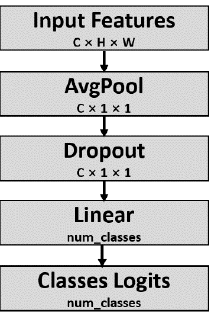
Figure 9. Structure of image classification head.